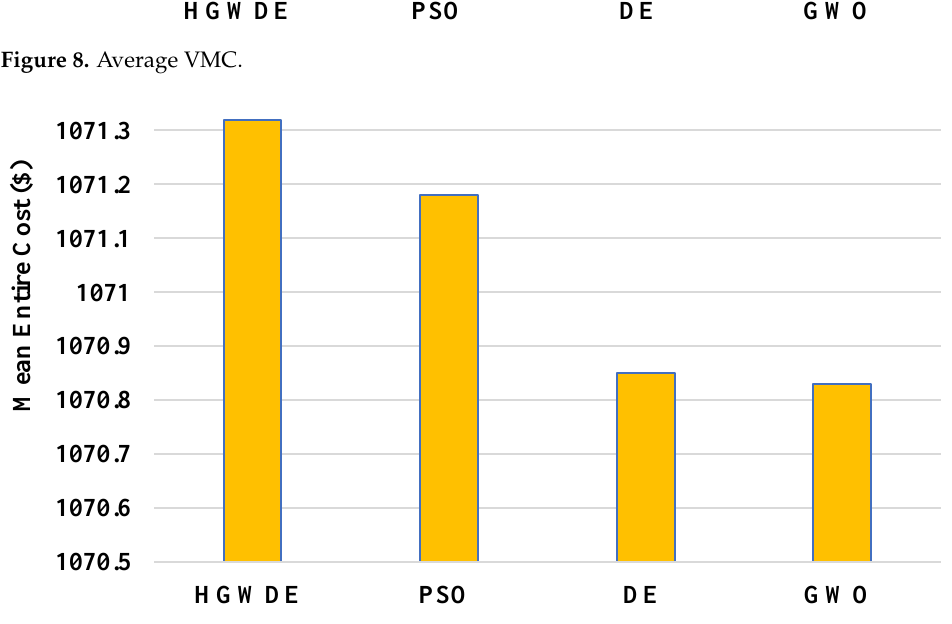
Figure 9. Average Figure 9. Average price. Figure 9. Average price.